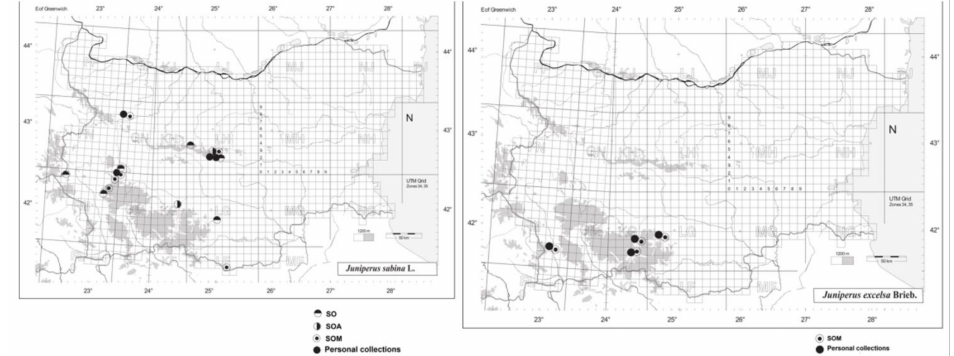
Figure 2. UTM map of the collection sites of J. sabina and J. excelsa in Bulgaria. SO; SOA; SOM— herbarium